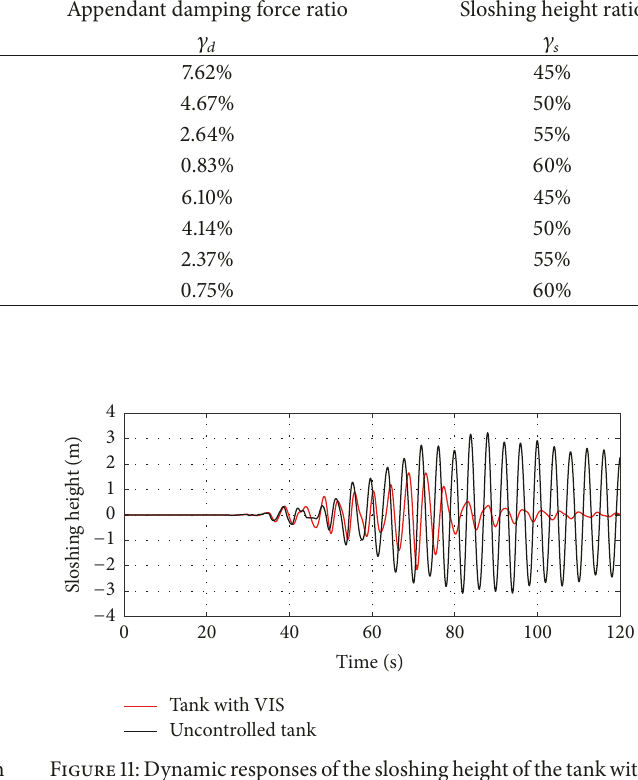
Figure 9: Dynamic responses of the sloshing height of the tank with the VIS under the excitation of the Coalinga earthquake.